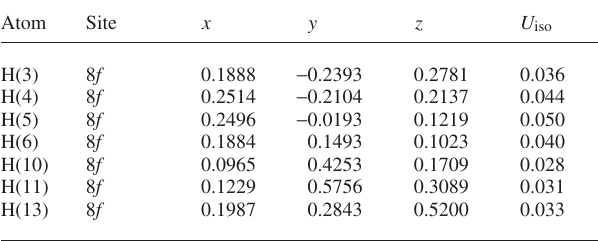
Table 2. Atomic coordinates and displacement parameters (in Å 2 )